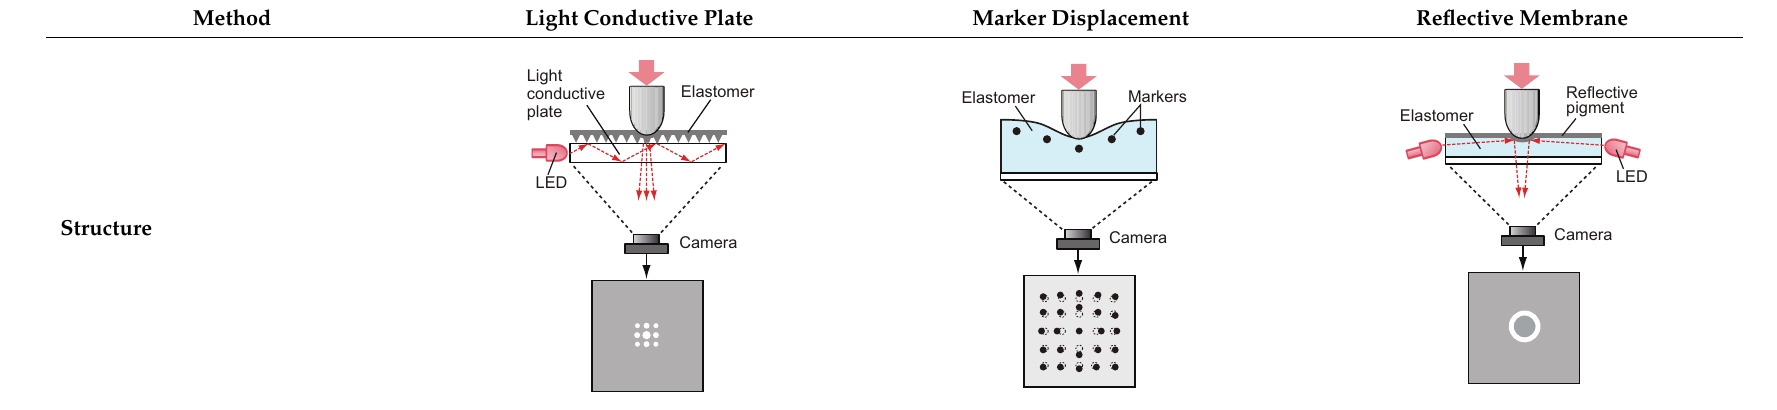
Table 1. Typical structures and features in typical three categories of tactile image sensors employing a camera, in terms of the conversion method from physical contact to light